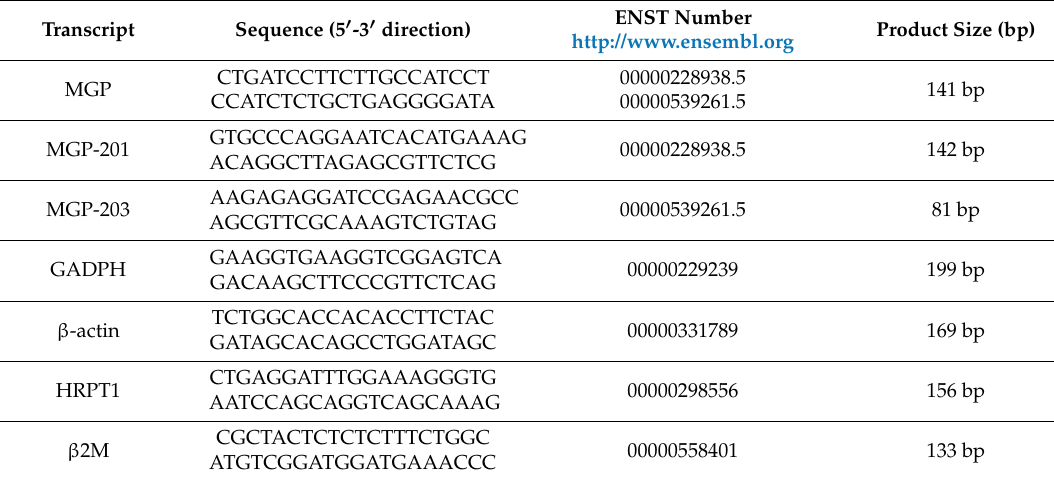
Table 1. Oligonucleotide sequences used for RQ-PCR